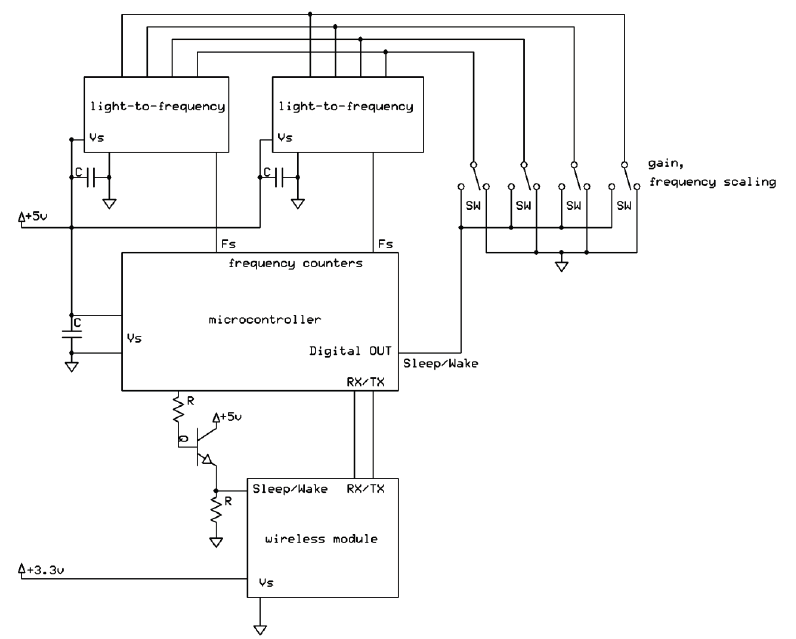
Figure 1. Schematic diagram of the electrical circuit showing the light-sensitive sensors, along with logic circuit and the wireless transmitter.